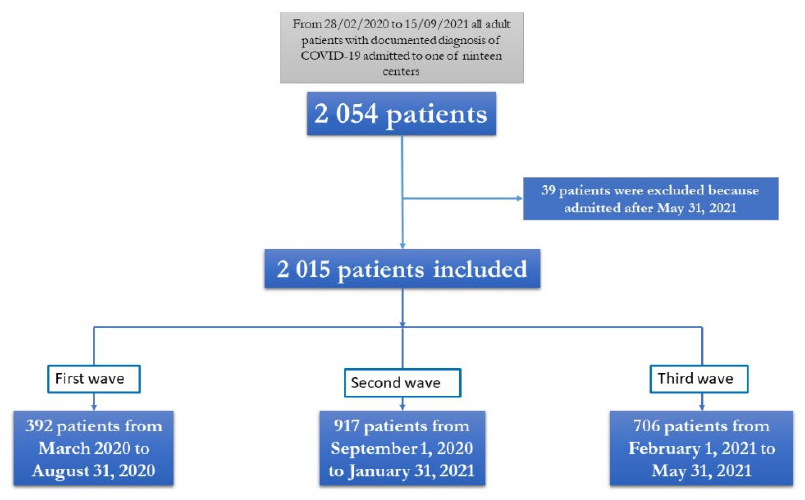
Figure 1. Study flow chart.